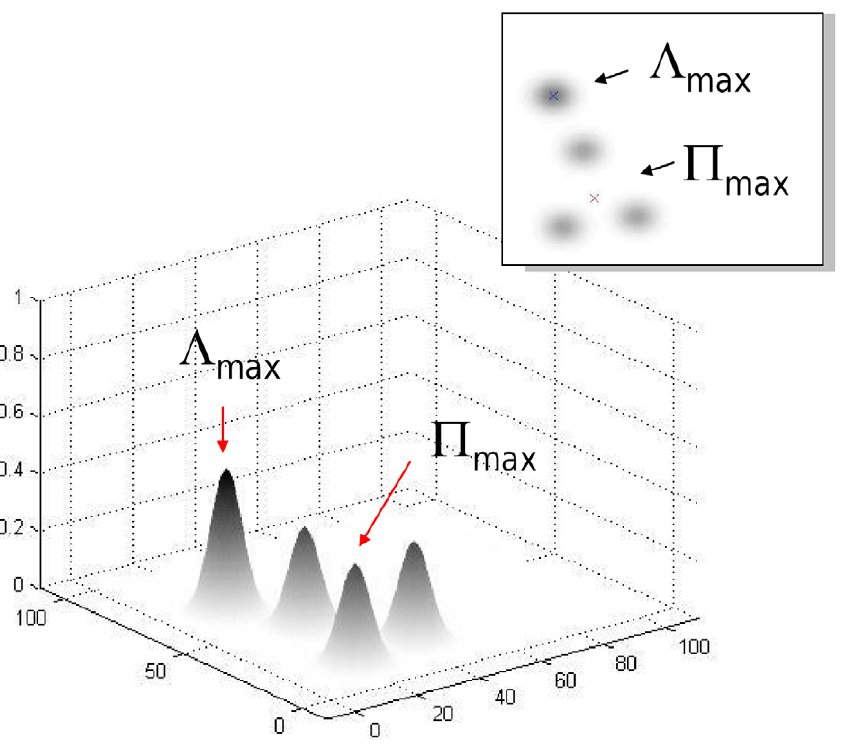
Figure 1. A likelihood map. The map is a plot of the likelihood that a specified target is present at each retinal location. The task is to select the retinal destination for the next saccade. Two strategies are illustrated. The first computes a saccade to the retinal location with highest likelihood ( L max ). The second computes a saccade that maximizes the probability of identifying the target location after the first saccade. We refer to the destination of this saccade as the P max . Najemnik & Geisler (2005) emphasized that L max and P max can be different when one takes into account the information gathering capabilities of the retina away from fovea and considers adaptive strategies that plan future saccades based on information gathered in previous saccades.